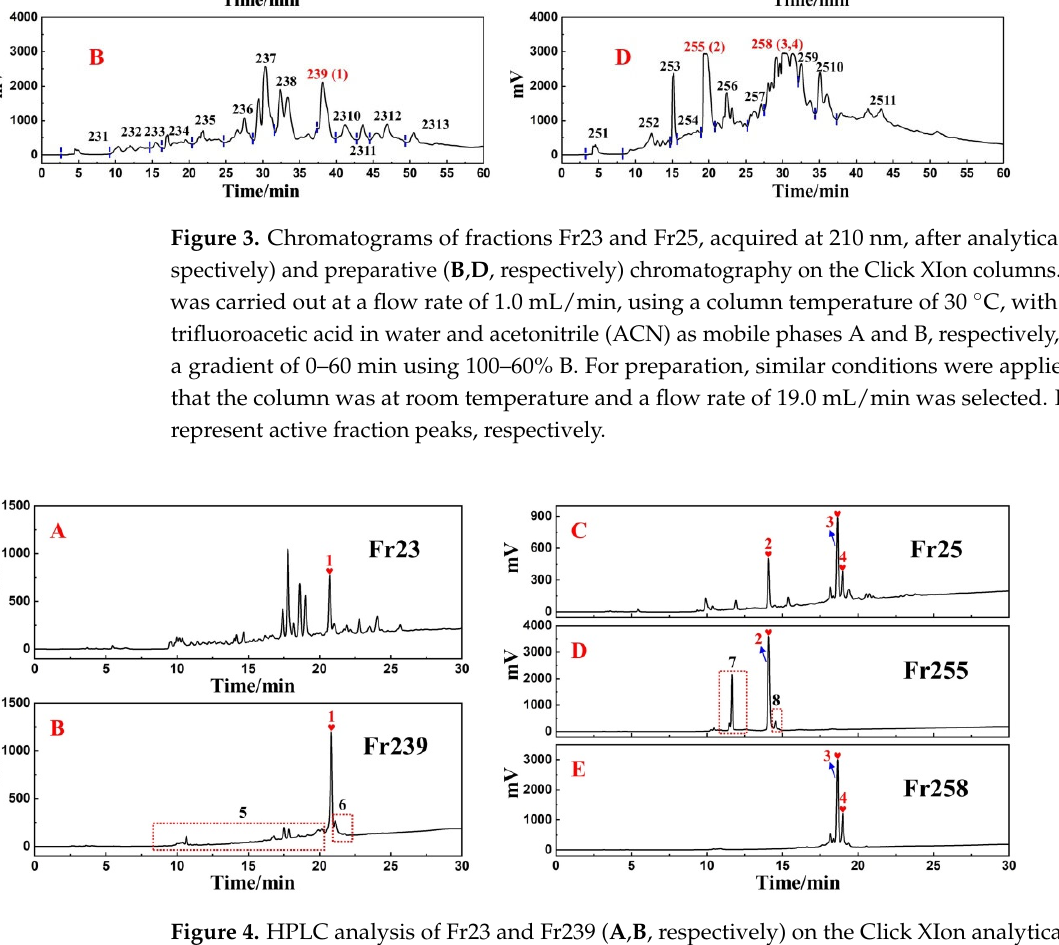
Figure 3. Chromatograms of fractions Fr23 and Fr25, acquired at 210 nm, after analytical ( A , C , re ‐ spectively) and preparative ( B , D , respectively) chromatography on the Click XIon columns. Analy ‐ sis was carried out at a flow rate of 1.0 mL/min, using a column temperature of 30 °C, with 0.1% v / v trifluoroacetic acid in water and acetonitrile (ACN) as mobile phases A and B, respectively, and with a gradient of 0–60 min using 100–60% B. For preparation, similar conditions were applied, except that the column was at room temperature and a flow rate of 19.0 mL/min was selected. Peaks 1 ‐ 4 represent active fraction peaks, respectively.